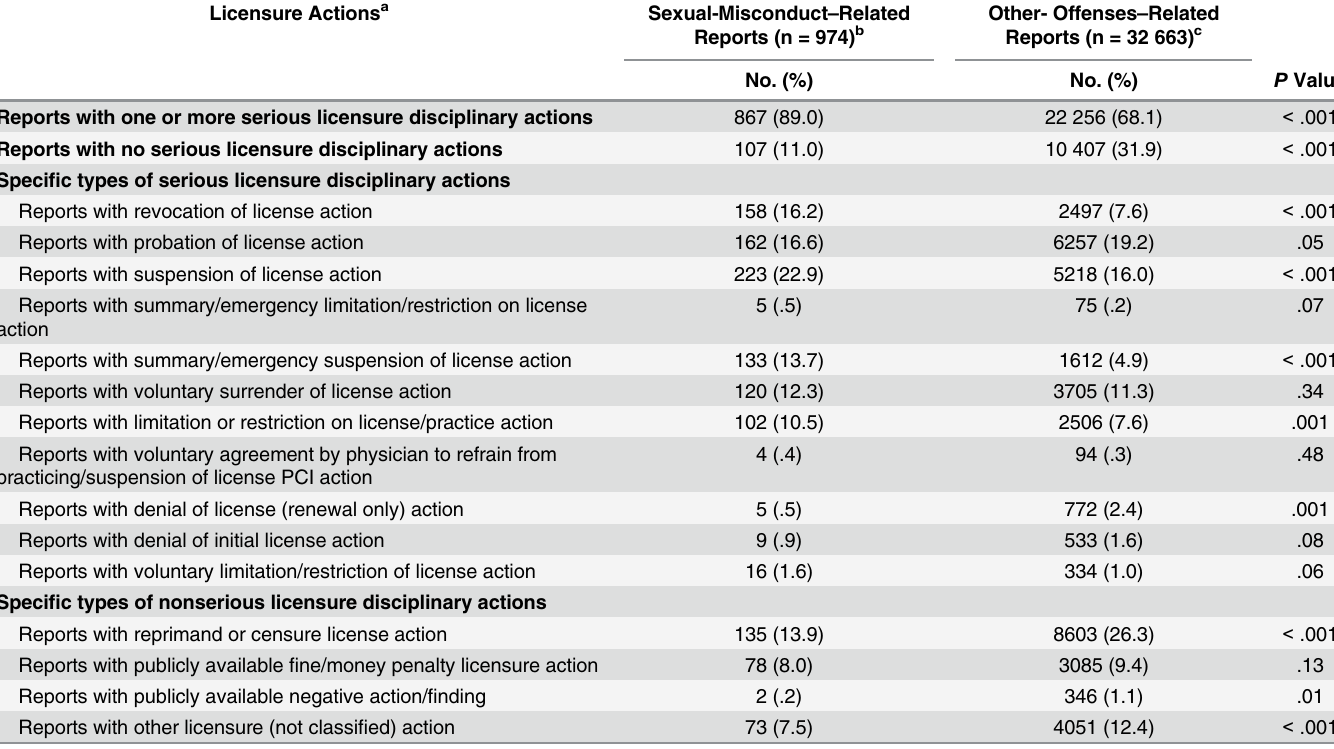
Table 4. Licensure Disciplinary Actions Taken Against Physicians in Sexual-Misconduct – Related vs Other-Offenses – Related Physician Licensure Reports (Report-Level